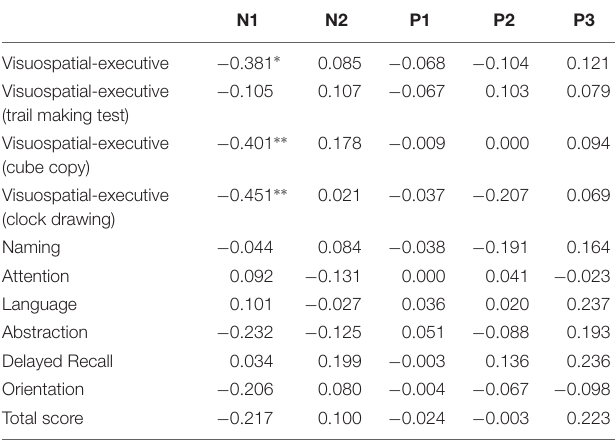
P = 0.008) and clock drawing test ( r s = − 0.523, P =